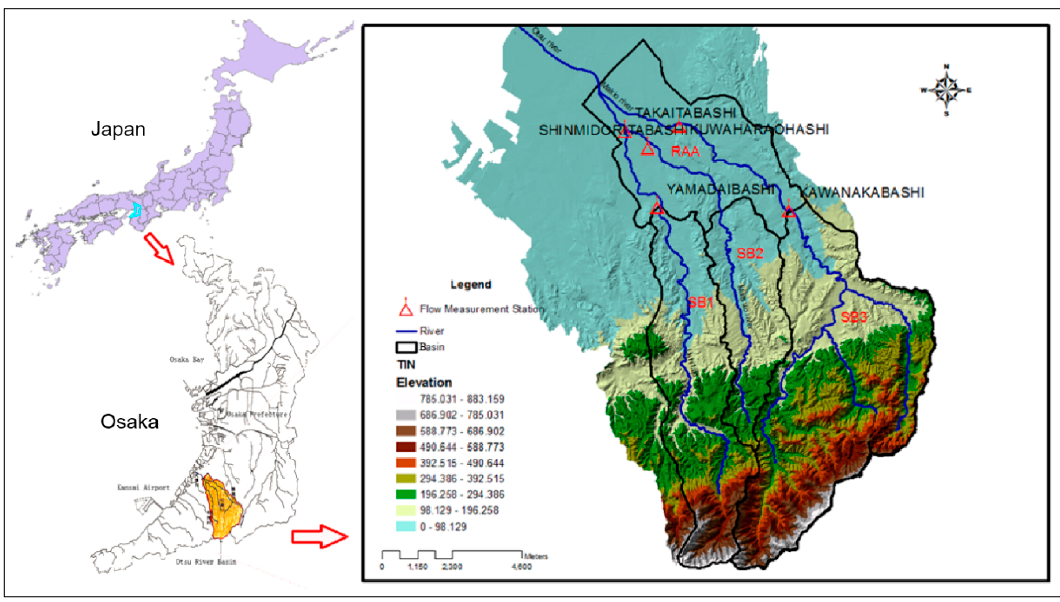
Figure 4. Map of the study area.